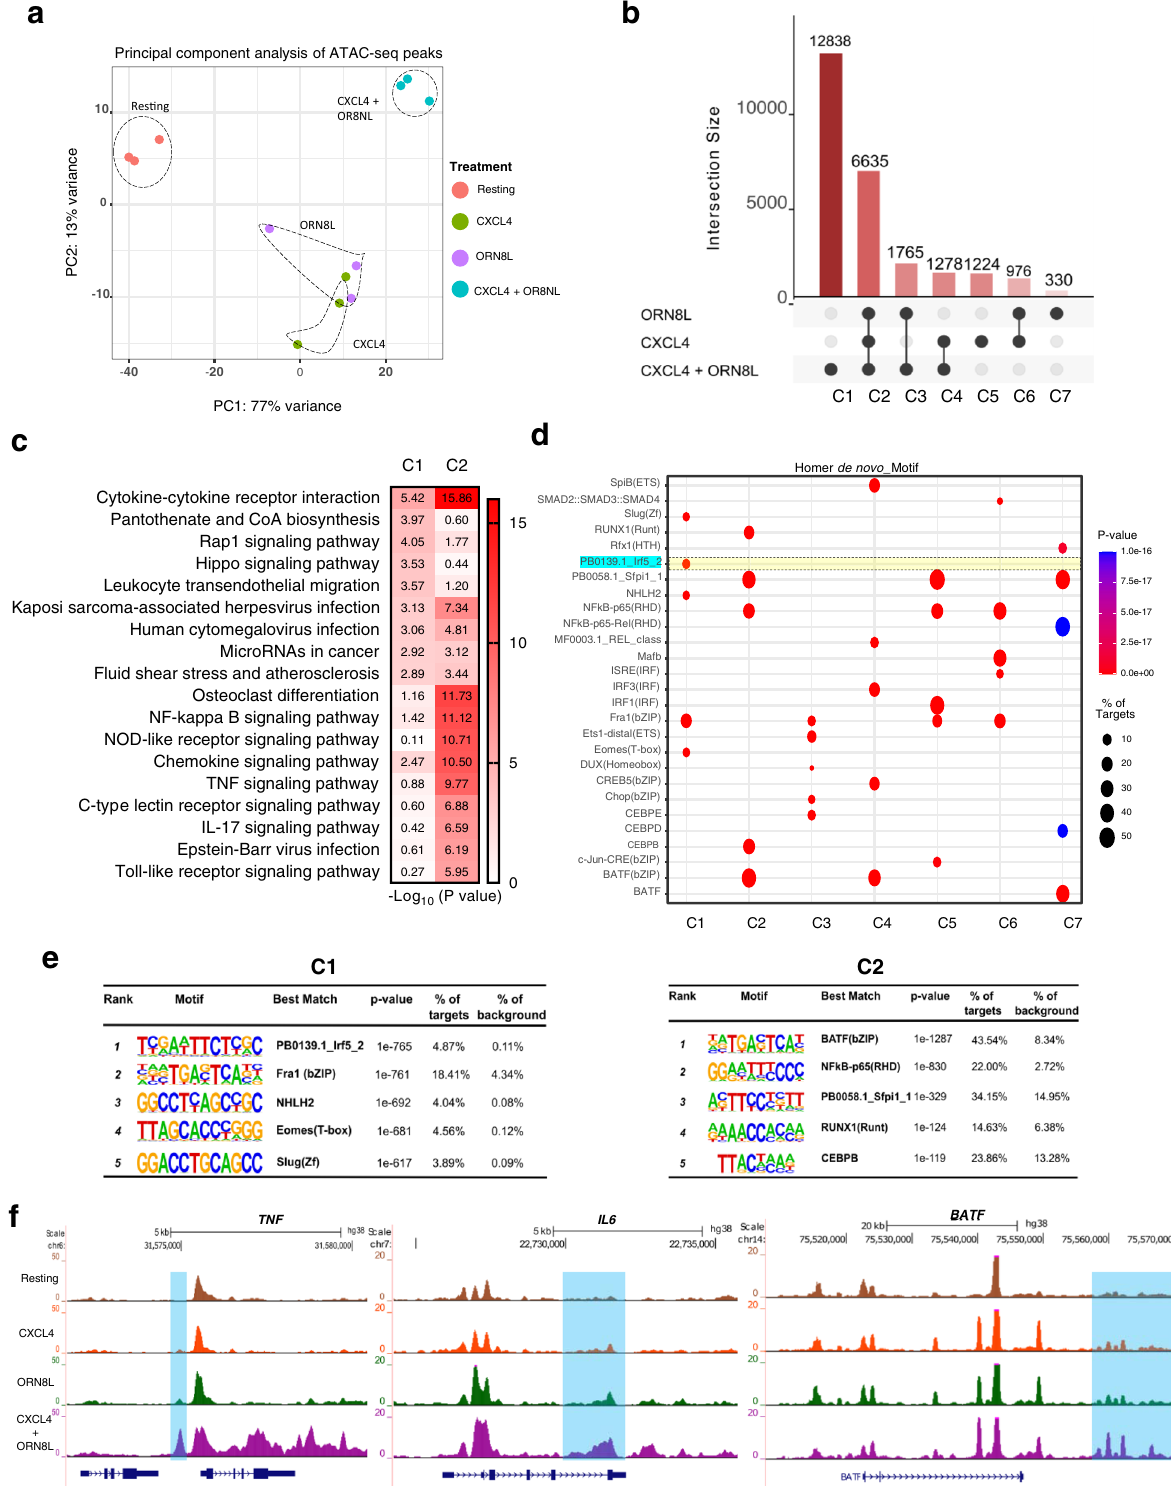
Fig. 5 CXCL4 and TLR8 costimulation induces unique open chromatin regions. a Principal component analysis (PCA) of a total of 76,8381 consensus ATAC-peaks for Resting, CXCL4, ORN8L, and (CXCL4 + ORN8L) treatments. b UpSet plot identifying distinct and overlapping open chromatin regions. Y-axis depicts the number of peaks and X-axis grouping of peaks by Clusters C1 – C7. c Functional enrichment analysis by Cistrome-GO of C1 and C2 peaks from ( b ). d Dot plot representation of top fi ve motifs identi fi ed by HOMER de novo motif analysis of C1 – C7 peaks. The dot size represents the percentage of peaks with the corresponding motif, and color represents signi fi cance ( p -value). e HOMER known motif analysis showing the top 5 signi fi cantly enriched motifs for C1 and C2. f UCSC genome browser tracks of normalized ATACseq signal at the TNF, IL6 , and BATF loci. ATACseq analysis ( a – f ) is based on 3 independent